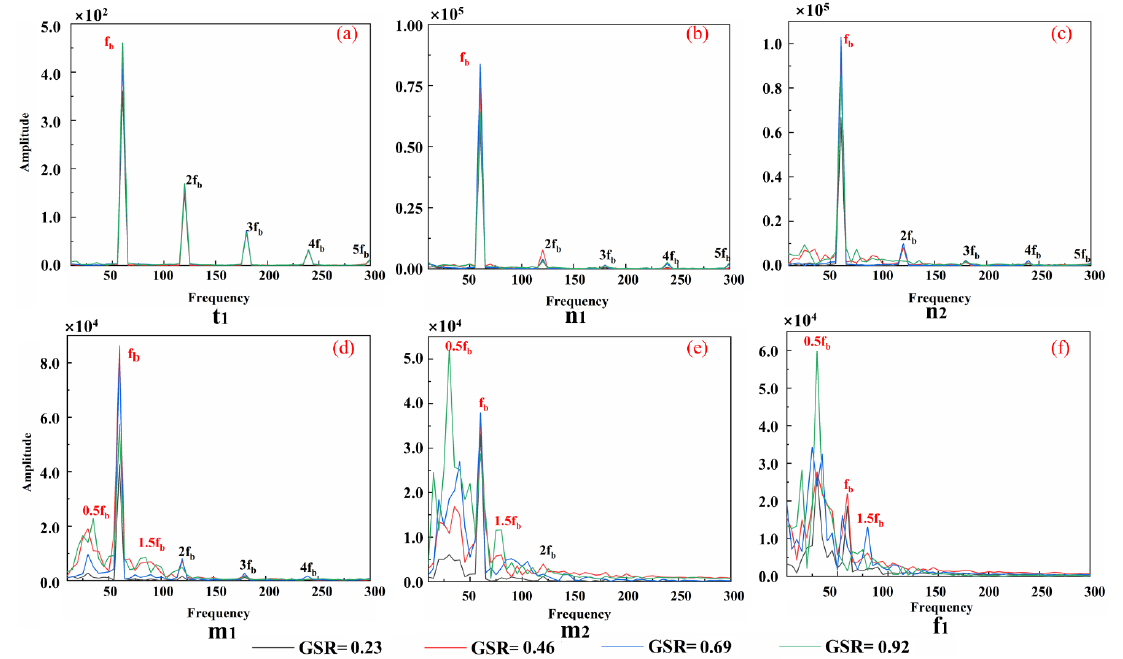
Figure 17. Diagram of pressure–frequency changes at the measuring points: ( a ) The frequency distribution of pressure at t 1 measuring point; ( b ) The frequency distribution of pressure at n 1 measuring point; ( c ) The frequency distribution of pressure at n 2 measuring point; ( d ) The frequency distribution of pressure at m 1 measuring point; ( e ) The frequency distribution of pressure at m 2 measuring point; ( f ) The frequency distribution of pressure at f 1 measuring point.